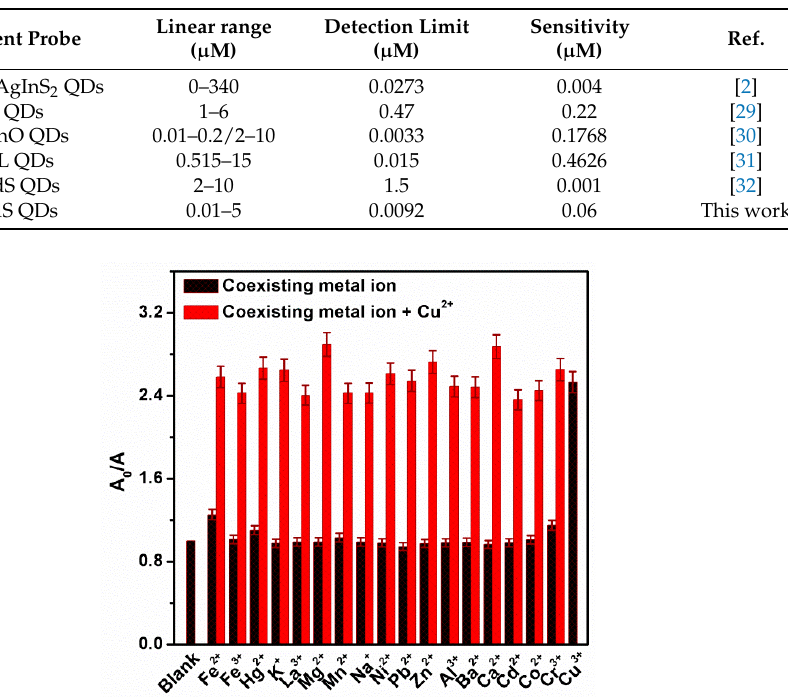
Table 3. Analytical results of tap water samples. Samples